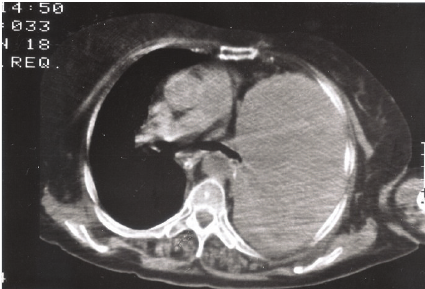
Figure2:Computedtomographyofthethoraxshowingalargemass in the left hemithorax.